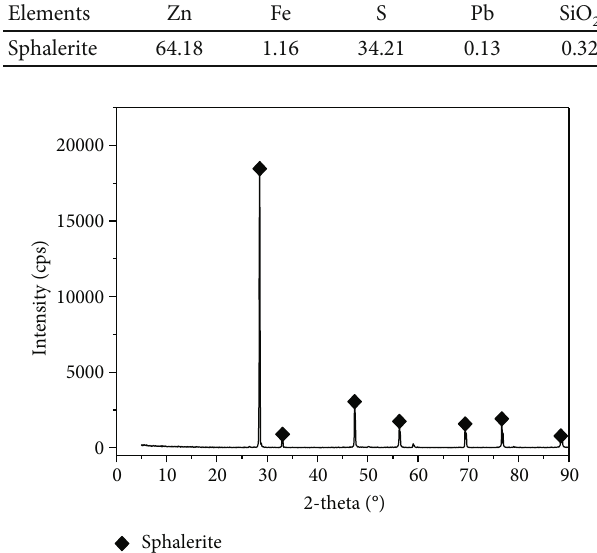
Figure 3: X-ray di ff raction spectrum of sphalerite.